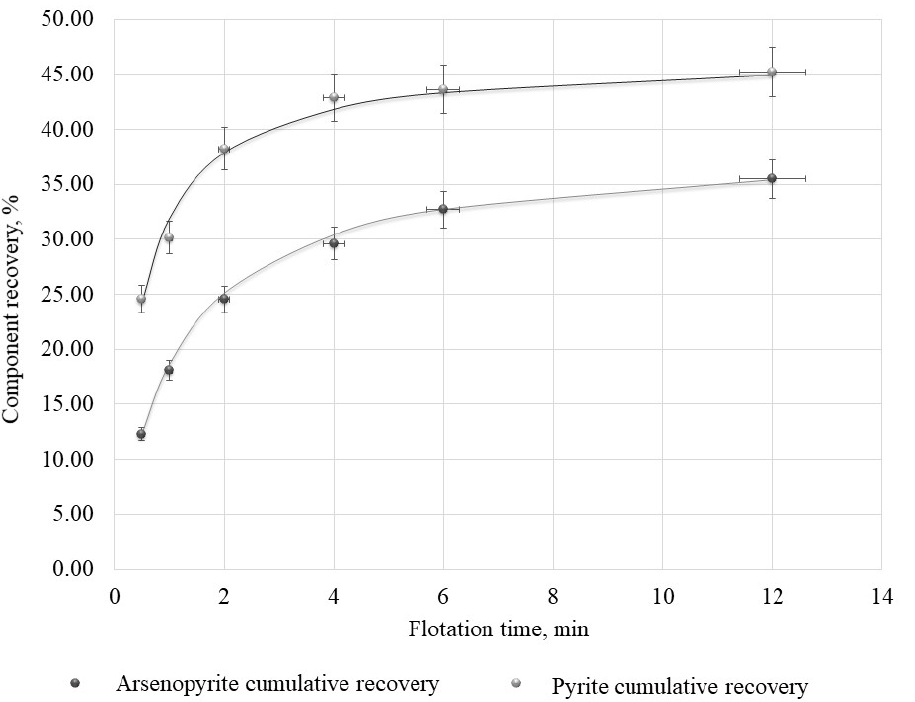
Figure 5. Recovery profiles for flotation with PNBX and SDBTP application.